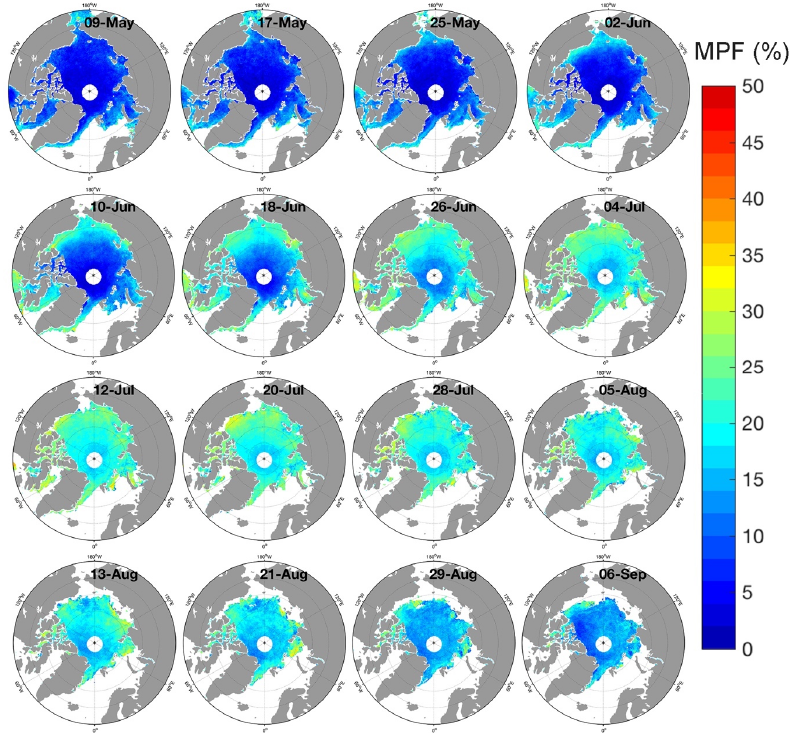
Figure 12. Averaged DNN_MPF for the period of May to September during 2003–2011.